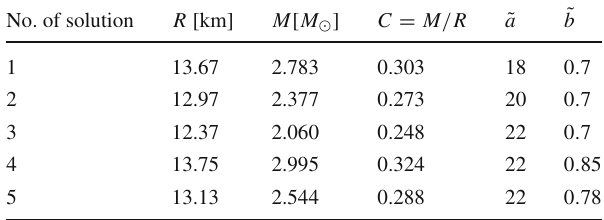
Table3 Propertiesoffiveinteriorsolutionsassumingapositive G (cid:5) ( r =